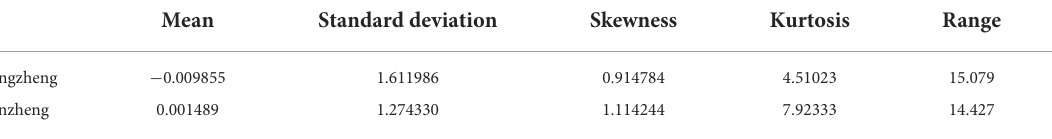
TABLE 2 Parameter estimation of the GARCH model.